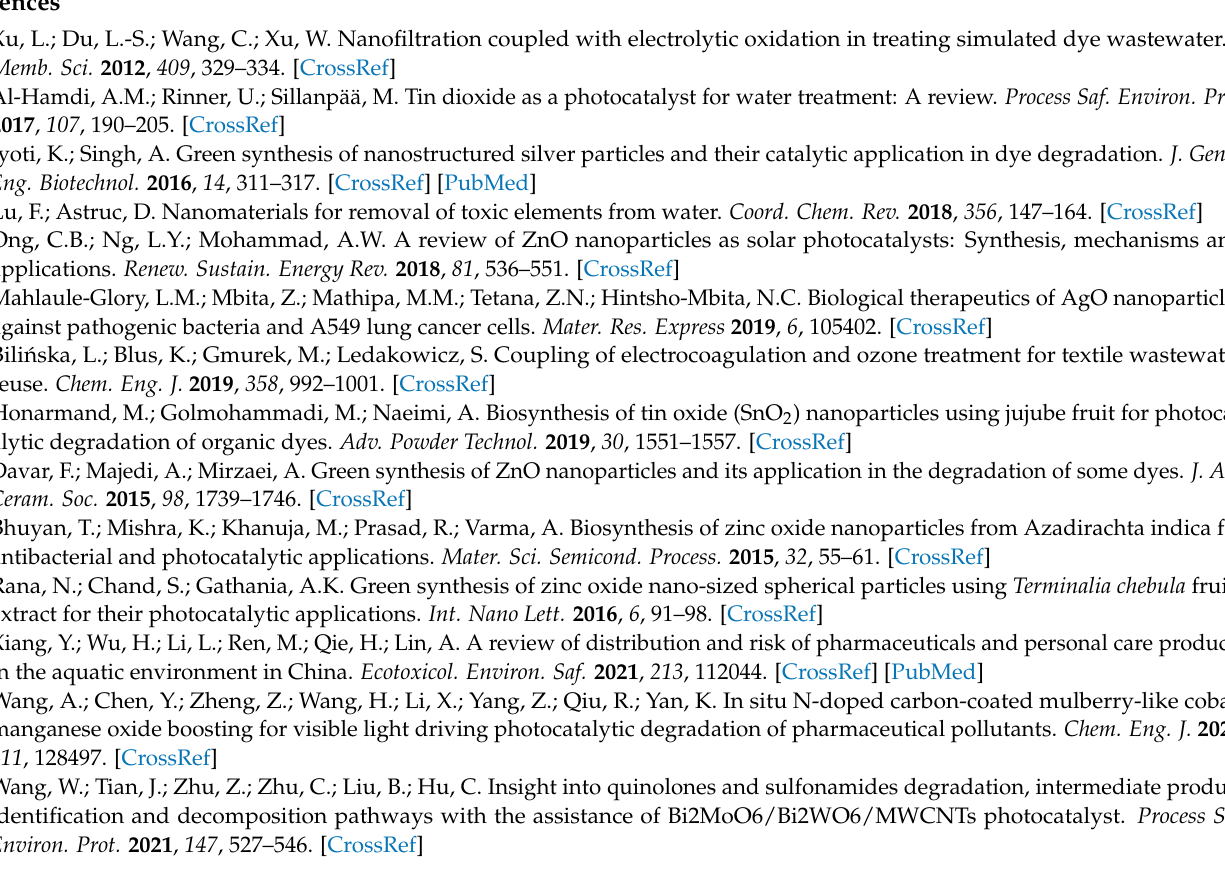
ticles; Figure S2: (a–f): Morphological analysis of the bimetallic nanoparticles at different resolutions, where (a) 30:70, (c) 50:50 and (e) 70:30 loadings at 100 nm whereas (b), (d) and (f) is at 50 nm, (g) particle size distribution; Figure S3: The images that exhibit the photocatalytic degradation of MB at different time intervals from 0–150